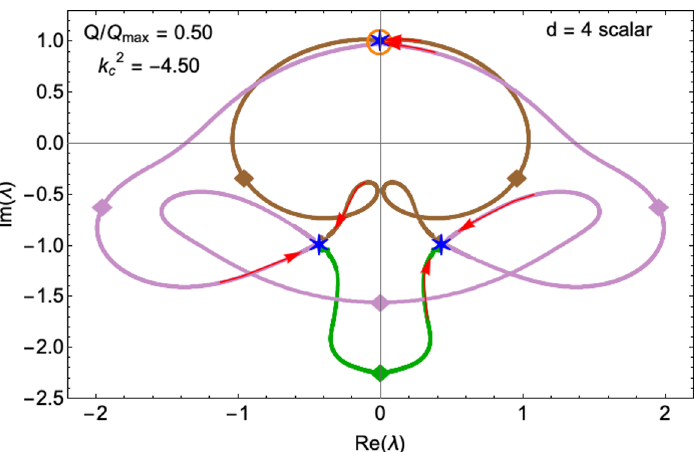
Figure 7 . Spectral curve of the hydrodynamic sound mode on the complex frequency plane for d = 4 ; ~ Q = Q=Q max = 0 : 5 at (cid:12)xed j k j 2 = 4 : 5. The brown line corresponds to the hydrodynamic sound mode, the green line to a di(cid:11)usive non-hydrodynamic mode in the sound channel and the lilac line to the di(cid:11)usion mode. This value of the momenta is beyond the radius of convergence and, in fact, lies along the subdominant blue branch. This is precisely the reason why we see collisions corresponding to the blue and the green branch at the locations indicated by the stars. The pole skipping point in marked with an orange circle and clearly lies along the hydrodynamic sound dispersion.